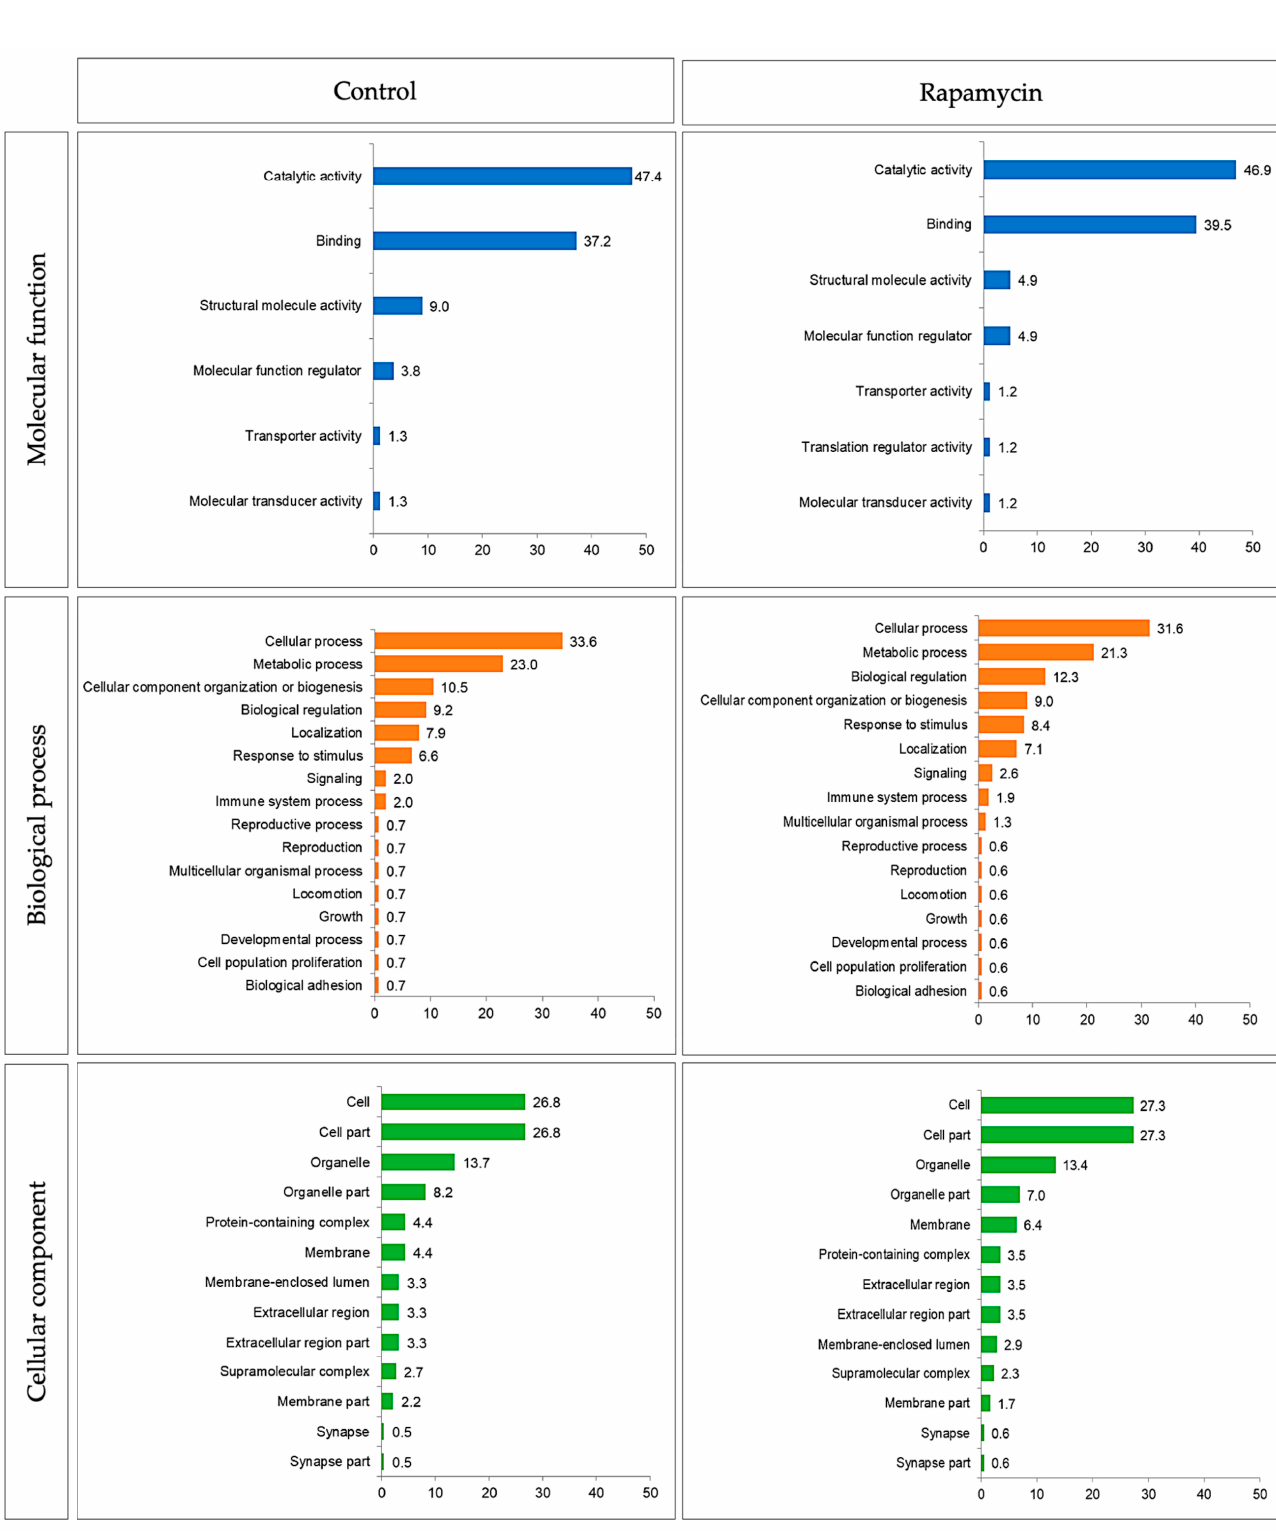
Figure 2. Gene ontology (molecular function, biological process, and cellular component) of control and rapamycin